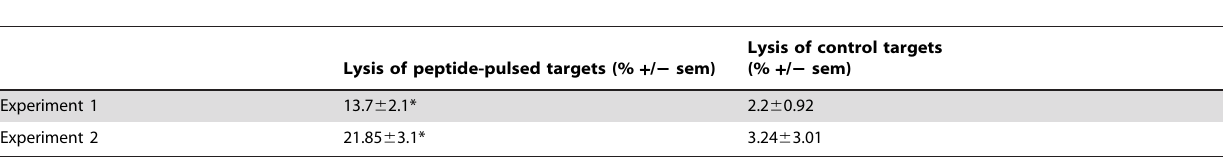
Table 2. In-vivo lysis of peptide-pulsed HLA-A2 cell targets by IGRP-specific CD8 T-cells.